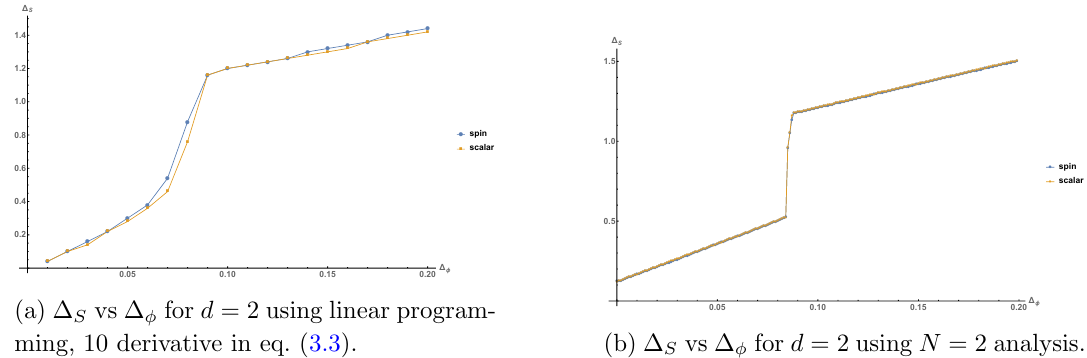
(a) (cid:1) S vs (cid:1) (cid:30) for d = 2 using linear program- ming, 10 derivative in eq. (3.3). Figure 11. Bound for the leading scalar dimension including spins in the spectrum. In each plot, the blue line is obtained considering up to spin ‘ = 6 in the analysis. Yellow line is only considering the scalar in the